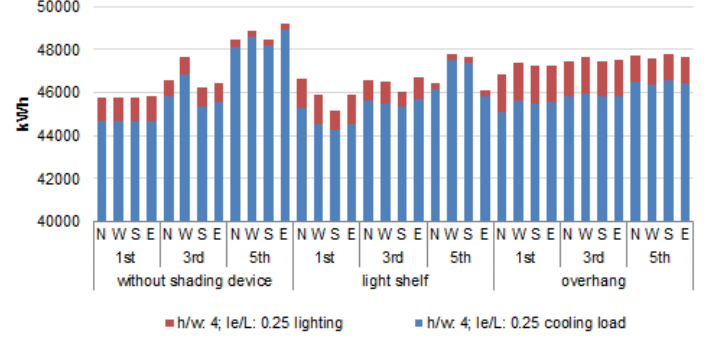
Fig. 11. A 9 m wide classrooms with various window orientations in highly dense urban area in Singapore.